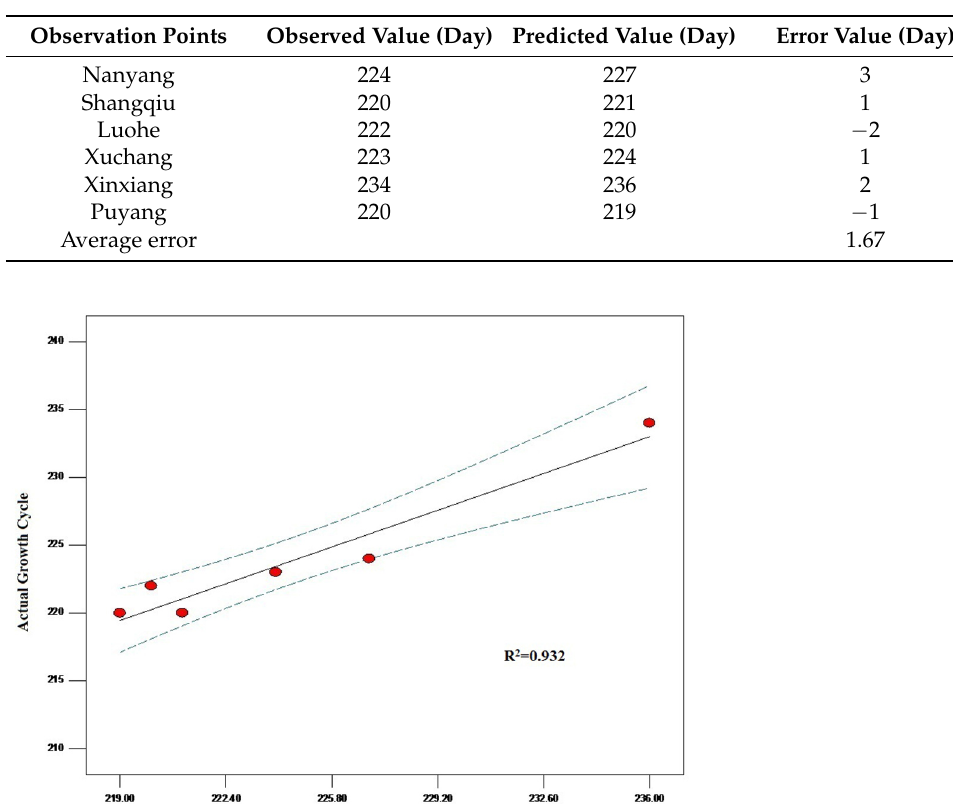
Table 10. Comparison of observed and forecasted values of the harvesting of winter wheat in Henan province in 2020.